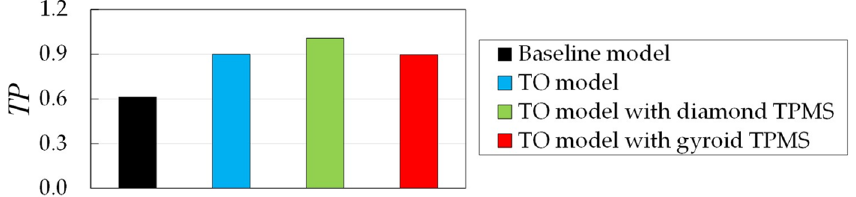
Figure 18. Thermal performances for all serpentine models at Re = 10,000.